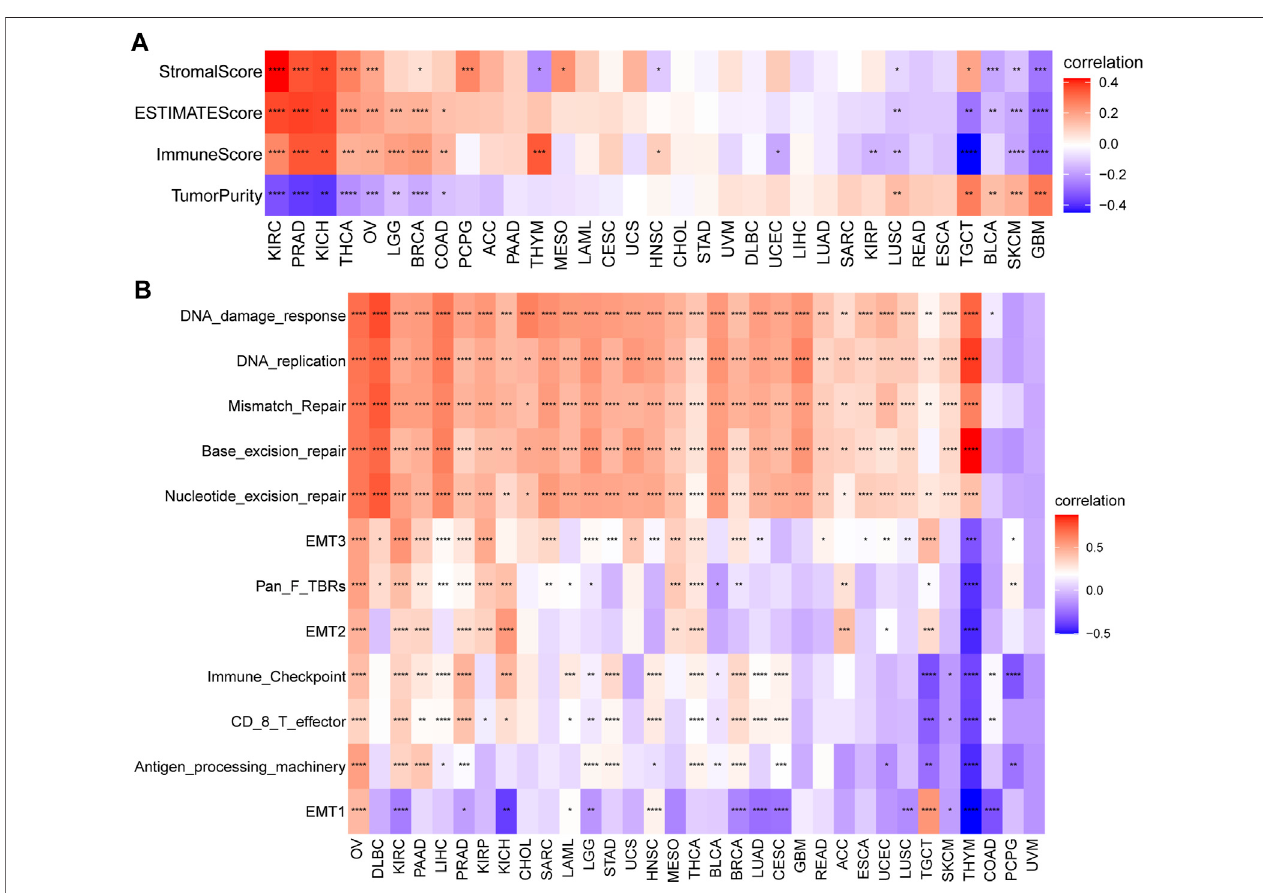
FIGURE10| Tumormicroenvironment(TME)analysisofsenescencescore(SS). (A) HeatmapindicatestheassociationbetweenSSandTMEscoreinpan-cancer. (B) The correlation between SS and biological processes in pan-cancer. Red depicts a positive correlation and blue a depicts negative correlation. Darker color depicts stronger correlations (Spearman correlation, p < 0.05 was considered signi fi cant, * p < 0.05, ** p < 0.01, *** p < 0.001, and **** p < 0.0001).